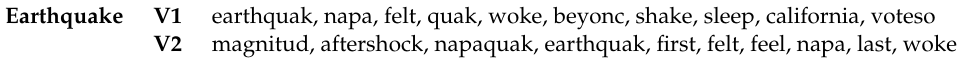
Table 4. Final set of seed words for the variants V1 (union vocabulary) and V2 (difference vocabulary) for the earthquake dataset. The number of seed words can differ as the biterms from Table 3 are split up. Earthquake